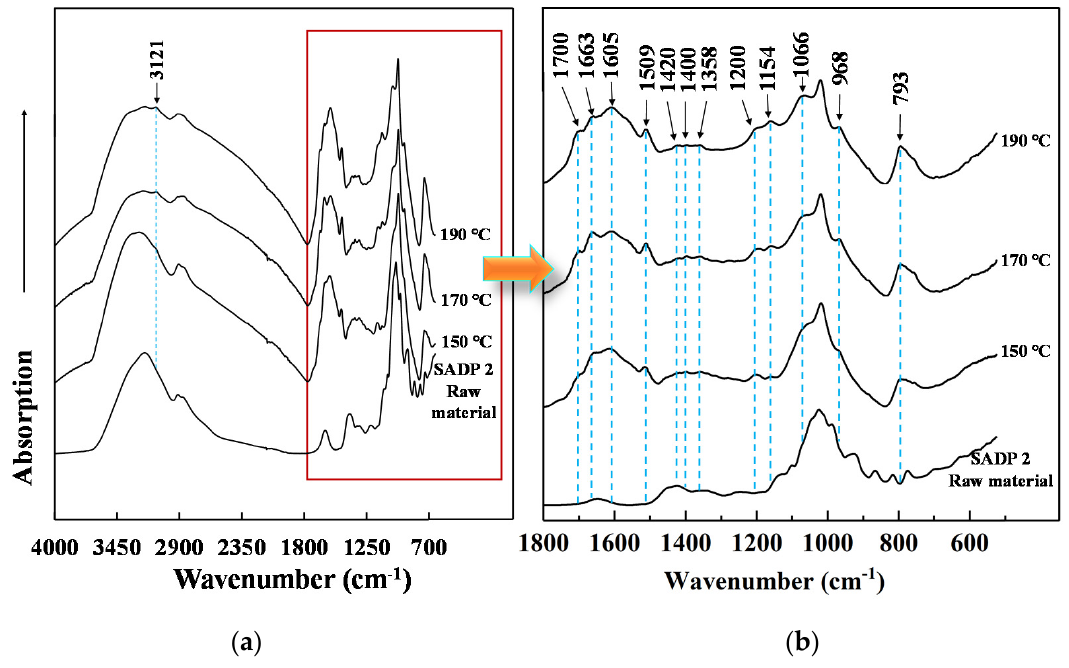
Figure 10. ATR FT-IR spectra of ( a ) insoluble matter derived from SADP 2 heated at di ff erent Figure 10. ATR FT ‐ IR spectra of ( a ) insoluble matter derived from SADP 2 heated at different temperatures. ( b ) Fractionated gain from 1800–500cm − 1 temperatures. ( b ) Fractionated gain from 1800–500cm − 1 .